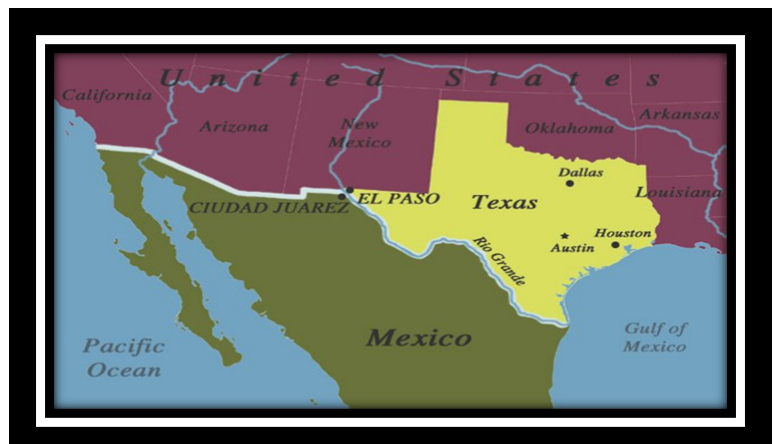
Figure 1. Map of the México-U.S.